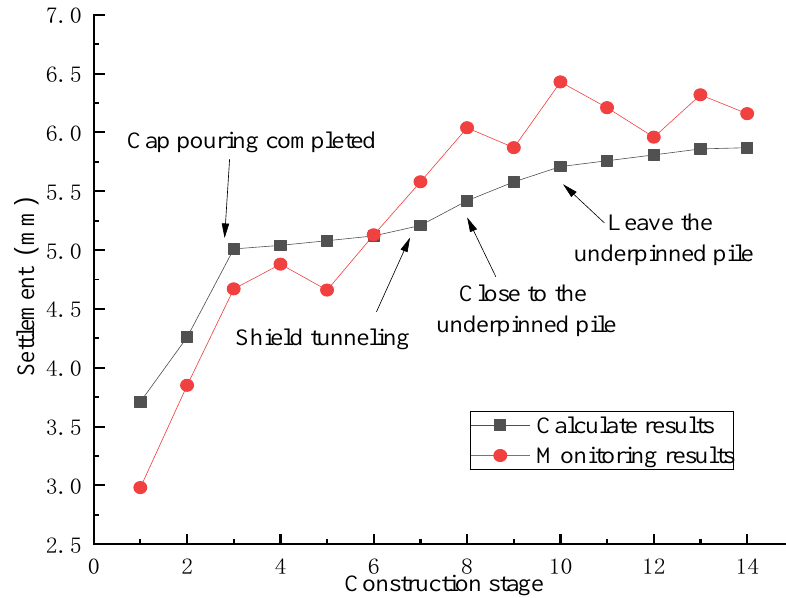
Figure 12. Vertical displacement results of the overpass pier.